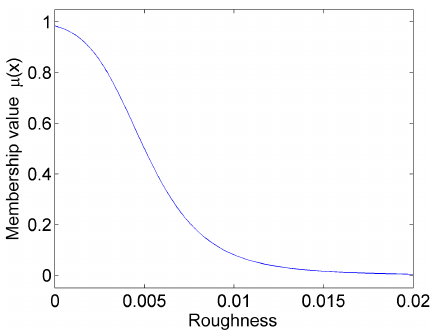
Figure 6. Fuzzy membership function for roughness.